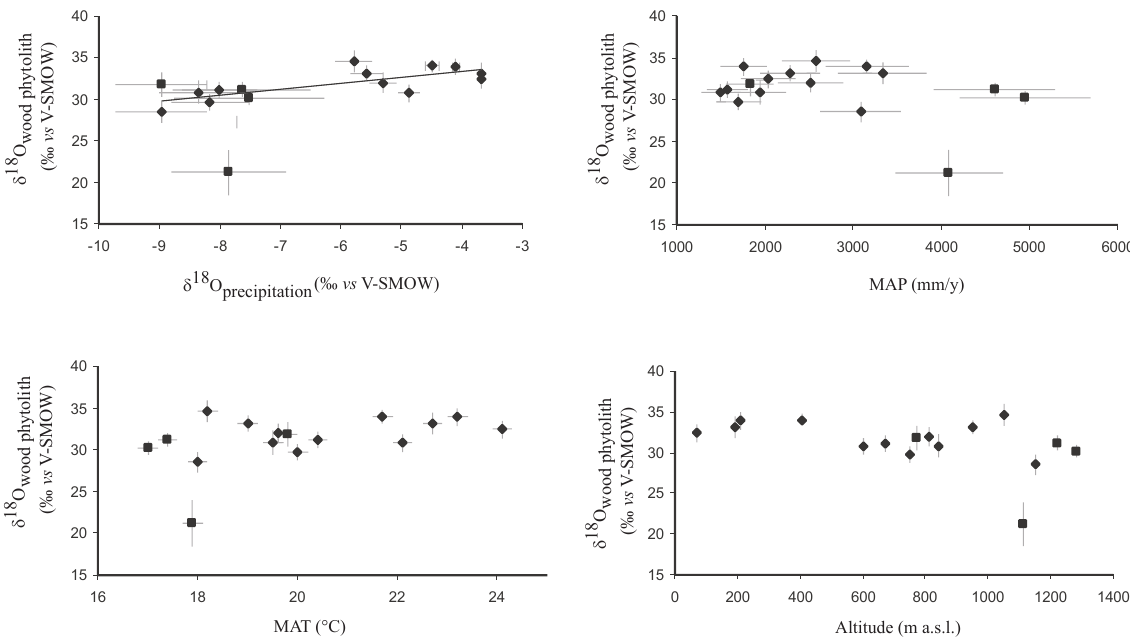
Altitude (m a.s.l.)